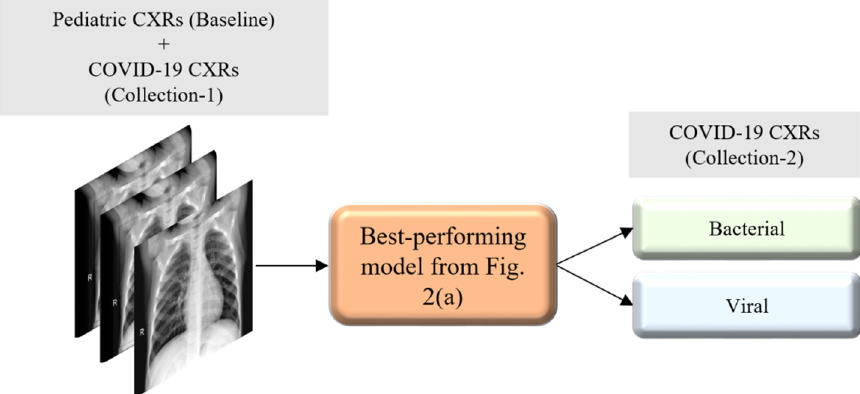
Figure 6. Evaluating the performance against a collection of COVID-19 CXRs when augmenting the best-performing weakly labeled augmented training data with a different collection of COVID-19 CXRs.